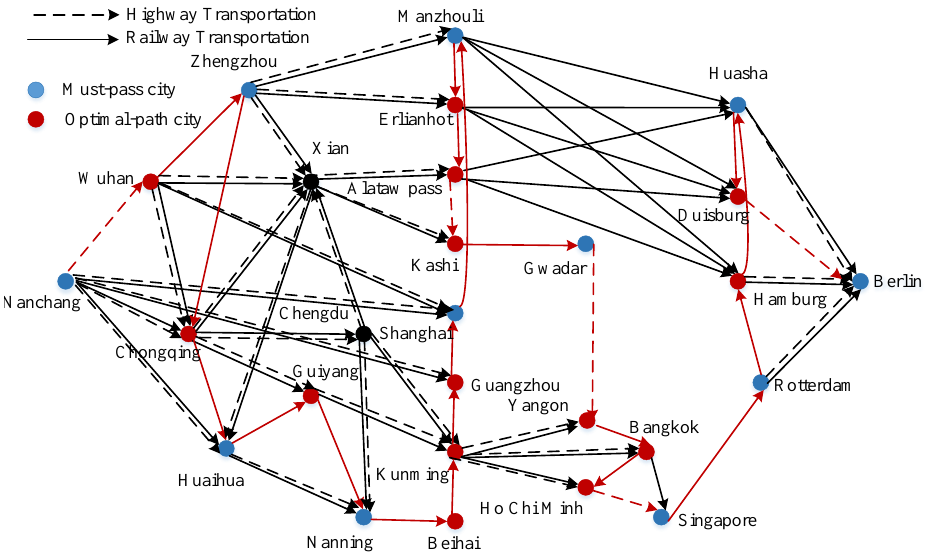
Figure 7. Optimization of Nanchang–Berlin multimodal transport network by general GA algorithm.